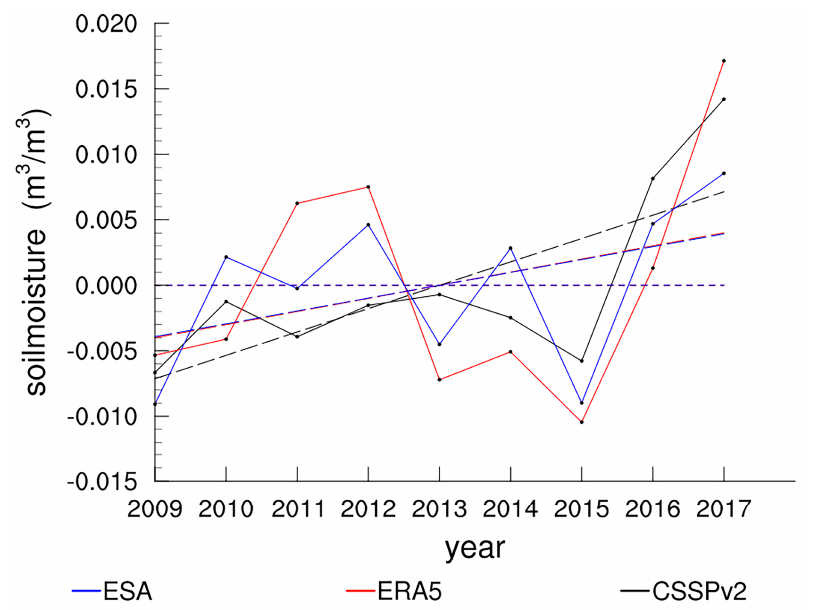
Figure 9. Anomaly variation of ESA, ERA5, and CSSPv2 surface soil moisture from April to September of 2009 to 2017. Dotted lines represent the linear regressions.